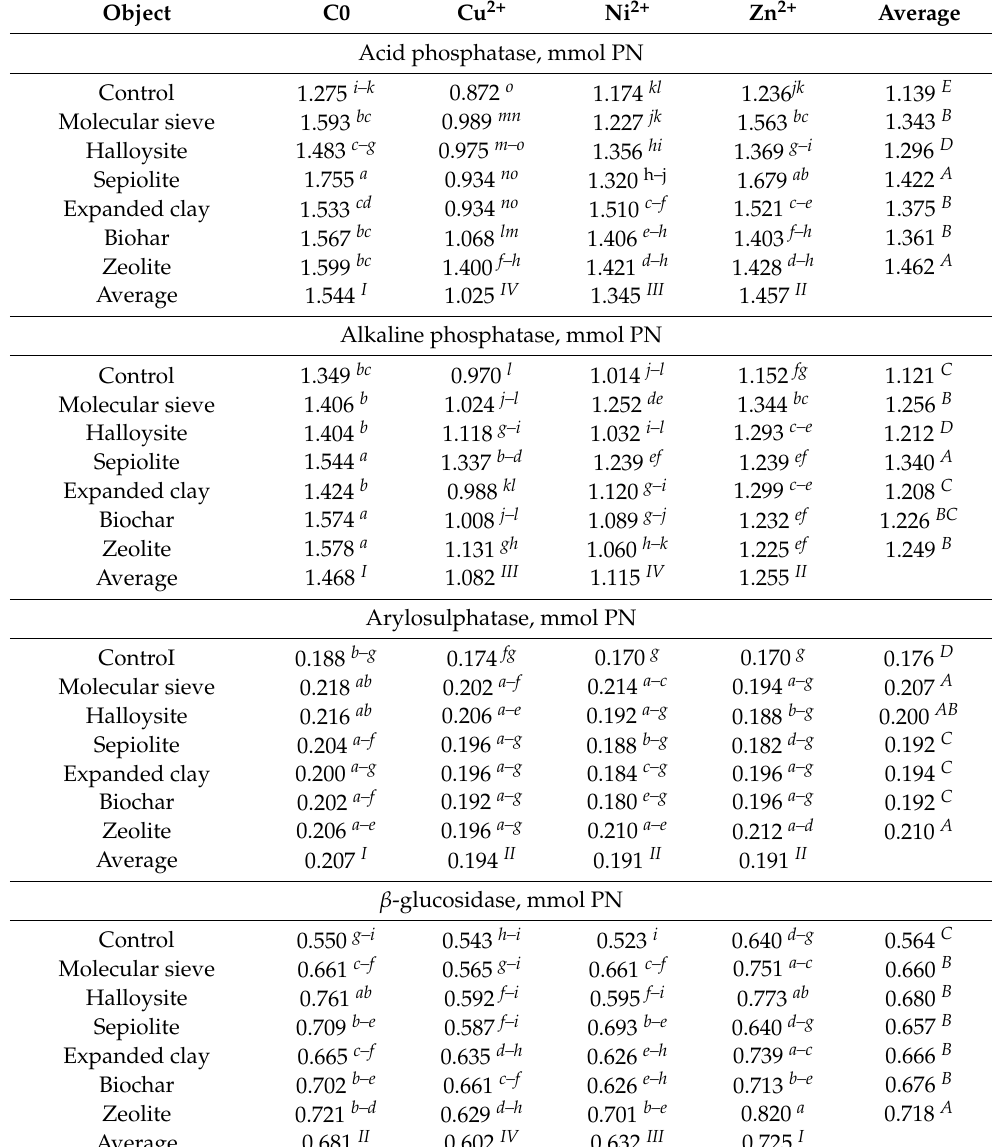
The abbreviations are explained under Table 1. Homogeneous groups were calculated separately for each enzyme (denoted with letters a–o), separately on average regardless of the metal used (denoted with letters A–E), or separately on average regardless of the adsorbents used (denoted with letters